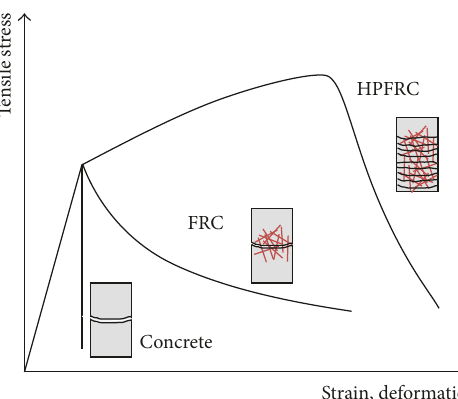
Figure 1: Tensile behavior of concrete, FRC, and HPFRC [7].